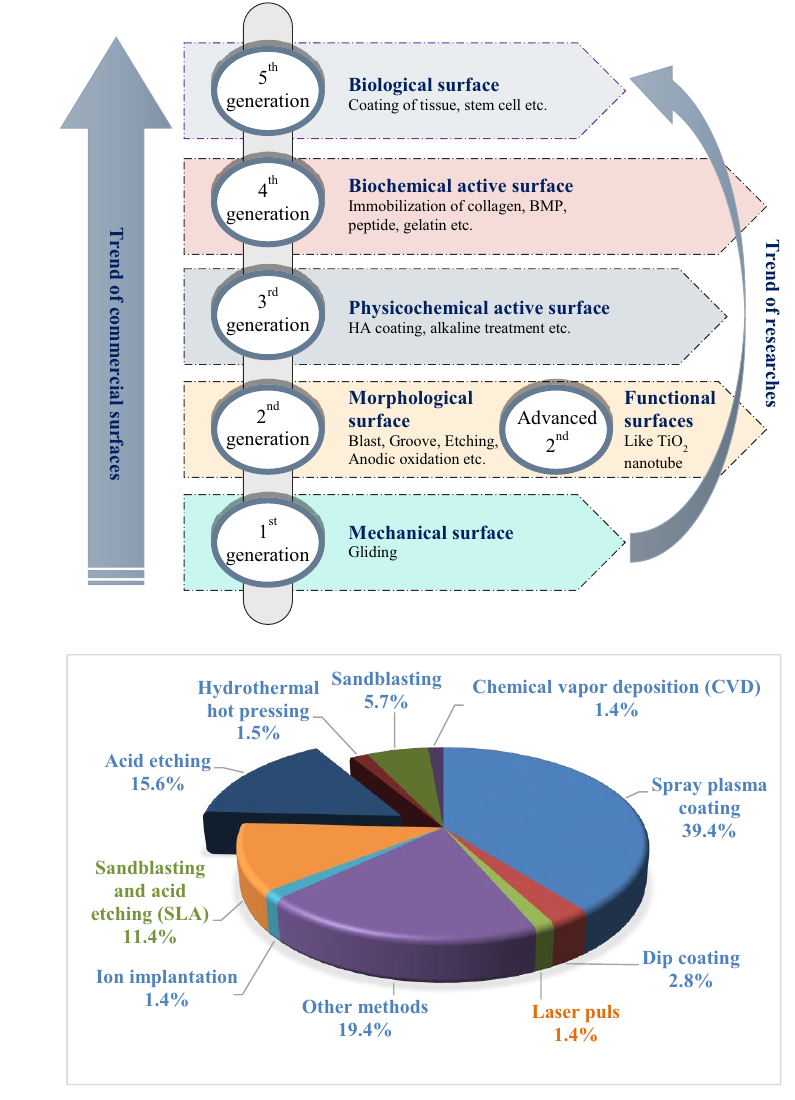
Figure 1. ( a ) Different generations of dental implant surface modifications, and ( b ) commonly used surface modification methods for titanium-based dental